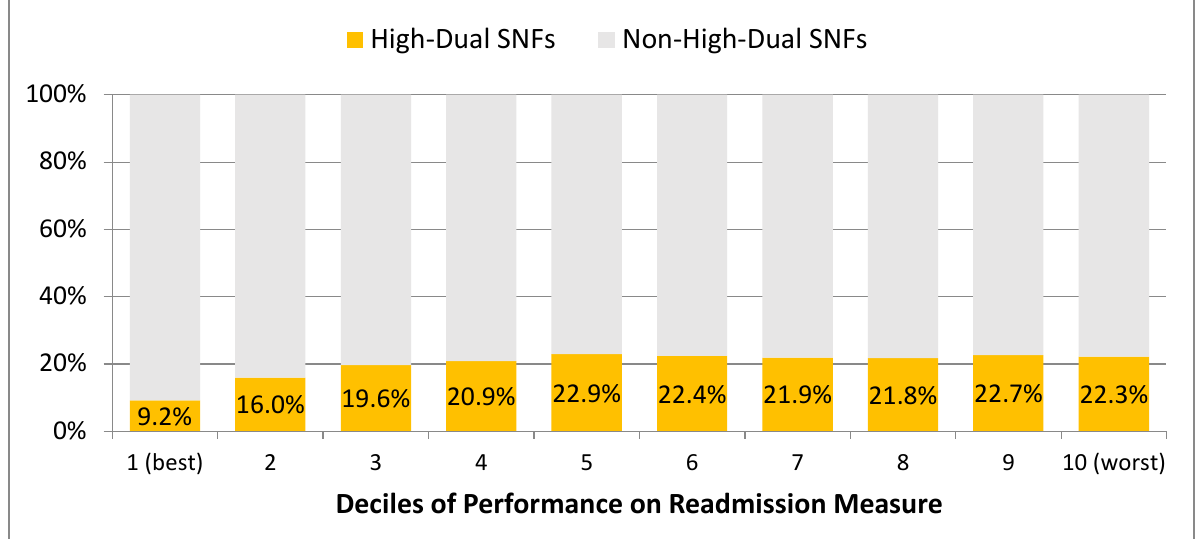
Figure 12.2: Distribution of High-Dually-enrolled SNFs in Deciles of Performance on Readmissions